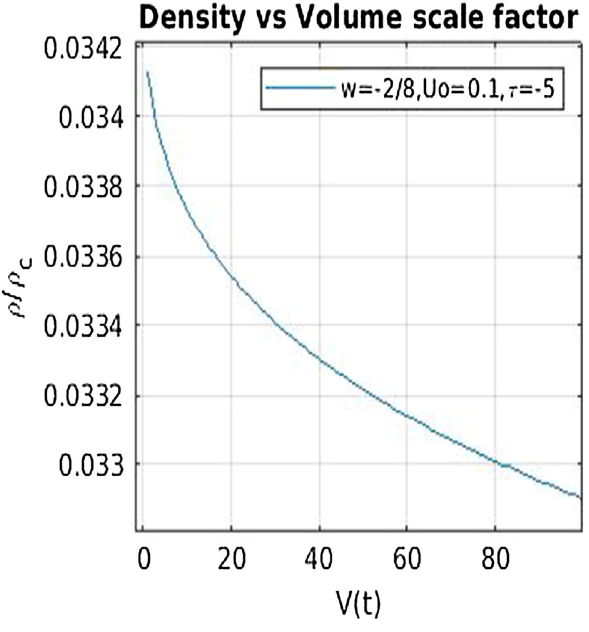
Fig. 2 Graph for energy density ( ρ) ; w = − 2